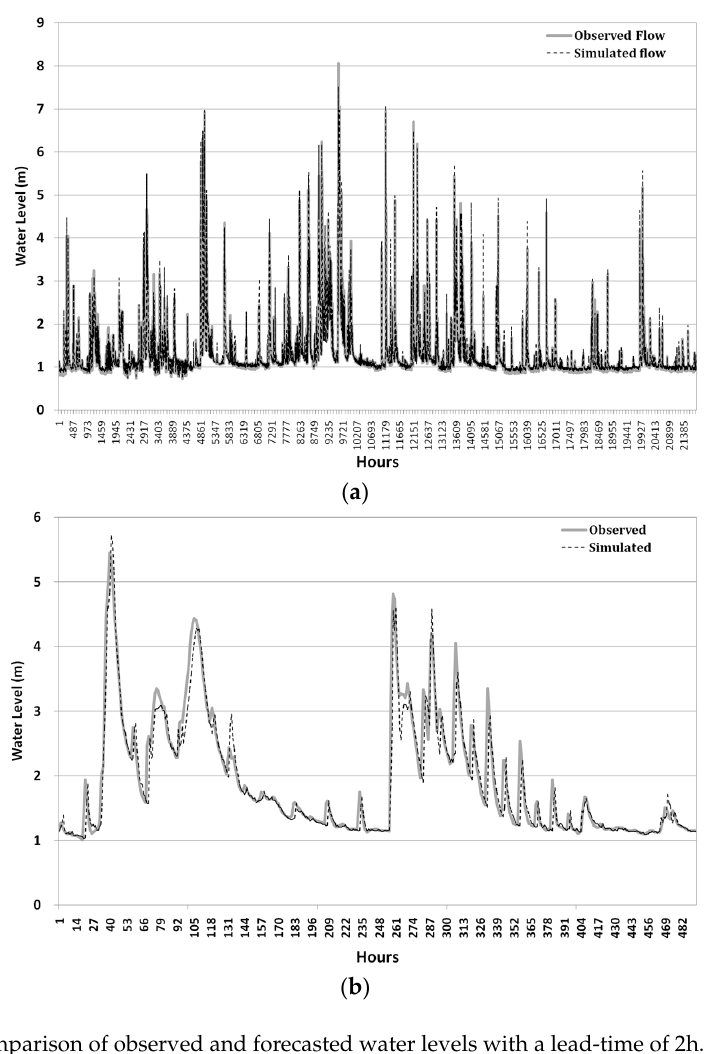
Figure 12. Comparison of observed and forecasted water levels with a lead-time of 2h. ( a ) Water level of training and testing periods; ( b ) Water level of some period in testing data set.